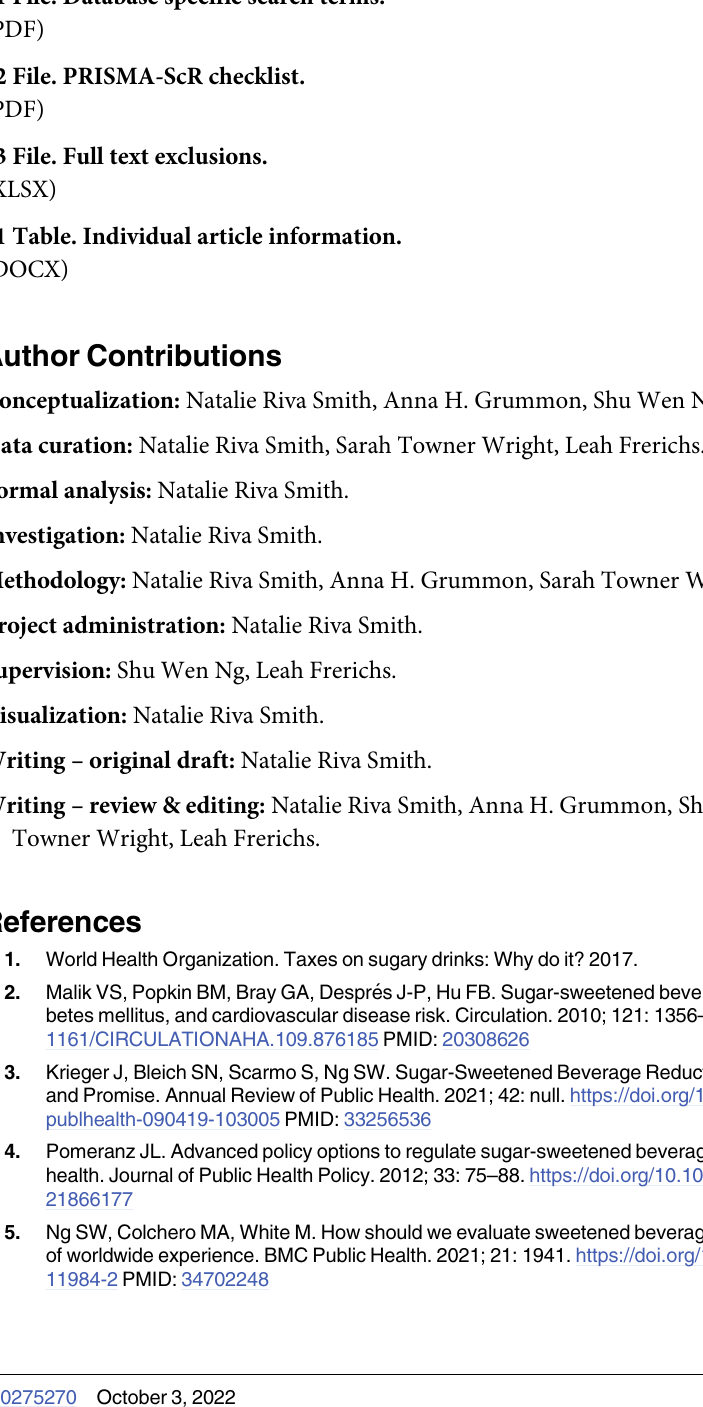
S1 Table. Individual article